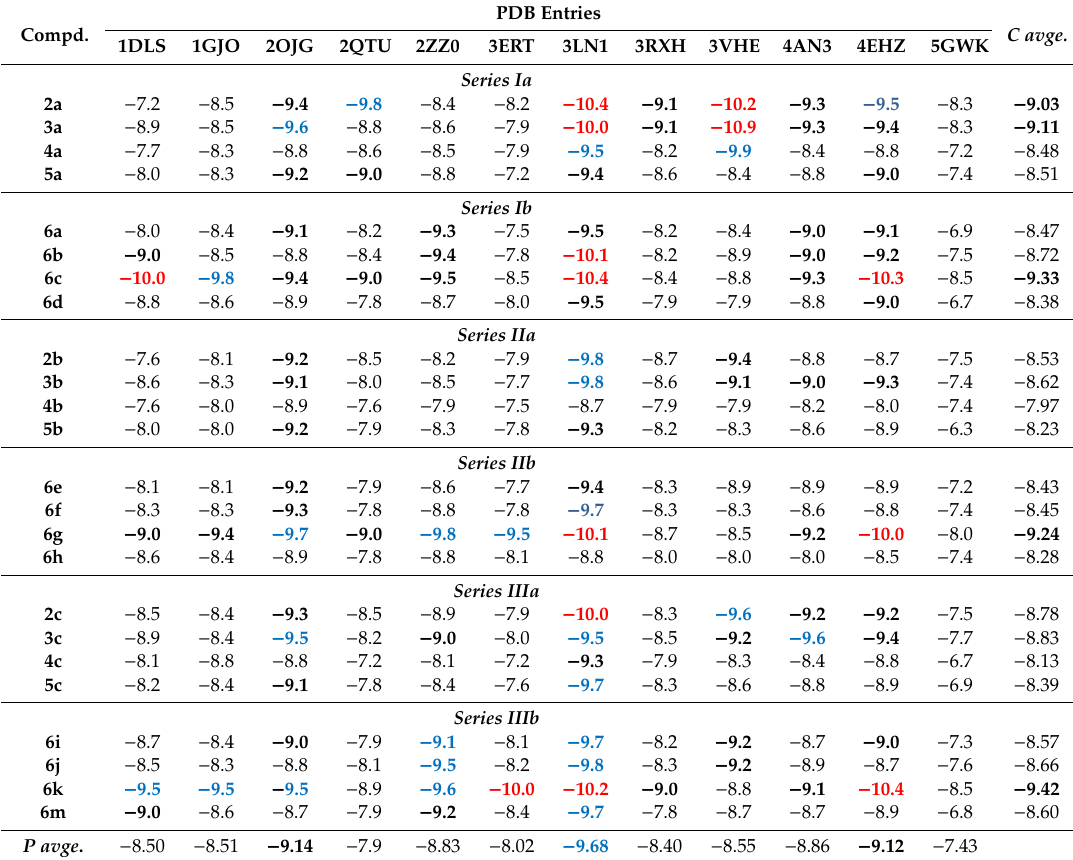
Table 1. Predicted binding free energy values ( ∆ G bin , kcal / mol) of the BIZQs from Series I, II, and III for cancer-related